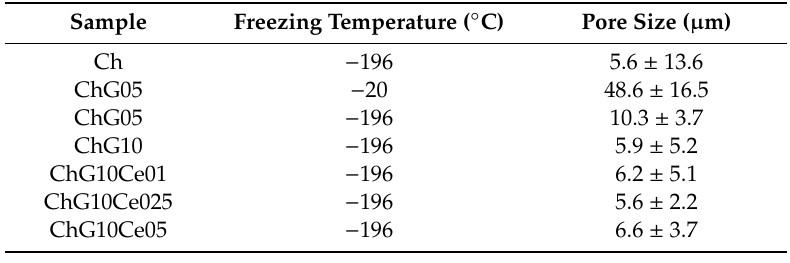
Figure 4. SEM images of surfaces of ChG05 chitosan − siloxane hybrid spheres prepared at − 20 and − 196 °C. Table 2. Pore sizes of the chitosan − siloxane spheres.